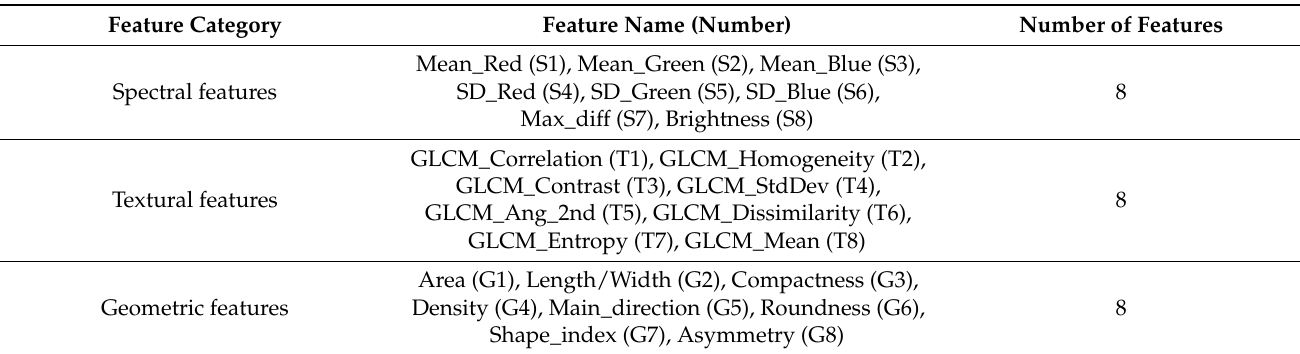
Table 2. Feature information and